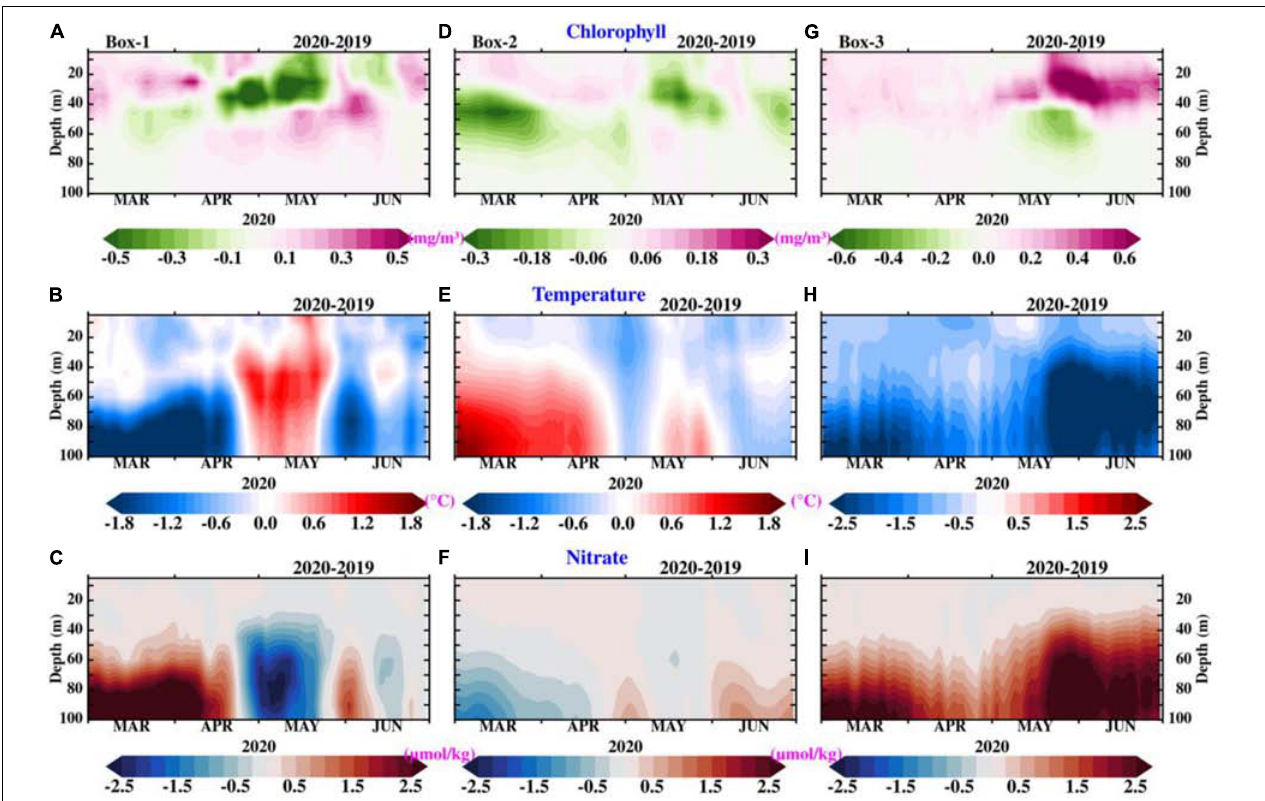
FIGURE 11 | Time-depth section of the difference of pandemic to the pre-pandemic period (the year 2020 – 2019) of model-simulated Chl-a concentration, temperature, and nitrate in the BoB averaged over (A–C) Box1 (85 ◦ E-87.5 ◦ E, 19 ◦ N-19.5 ◦ N), (D–F) Box2 (80.6 ◦ E-83 ◦ E, 12 ◦ N-15.5 ◦ N), and (G–I) Box3 (82 ◦ E-90 ◦ E, 4 ◦ N-9 ◦ N) regions. Box1, Box2, and Box3 are marked in Figure 1